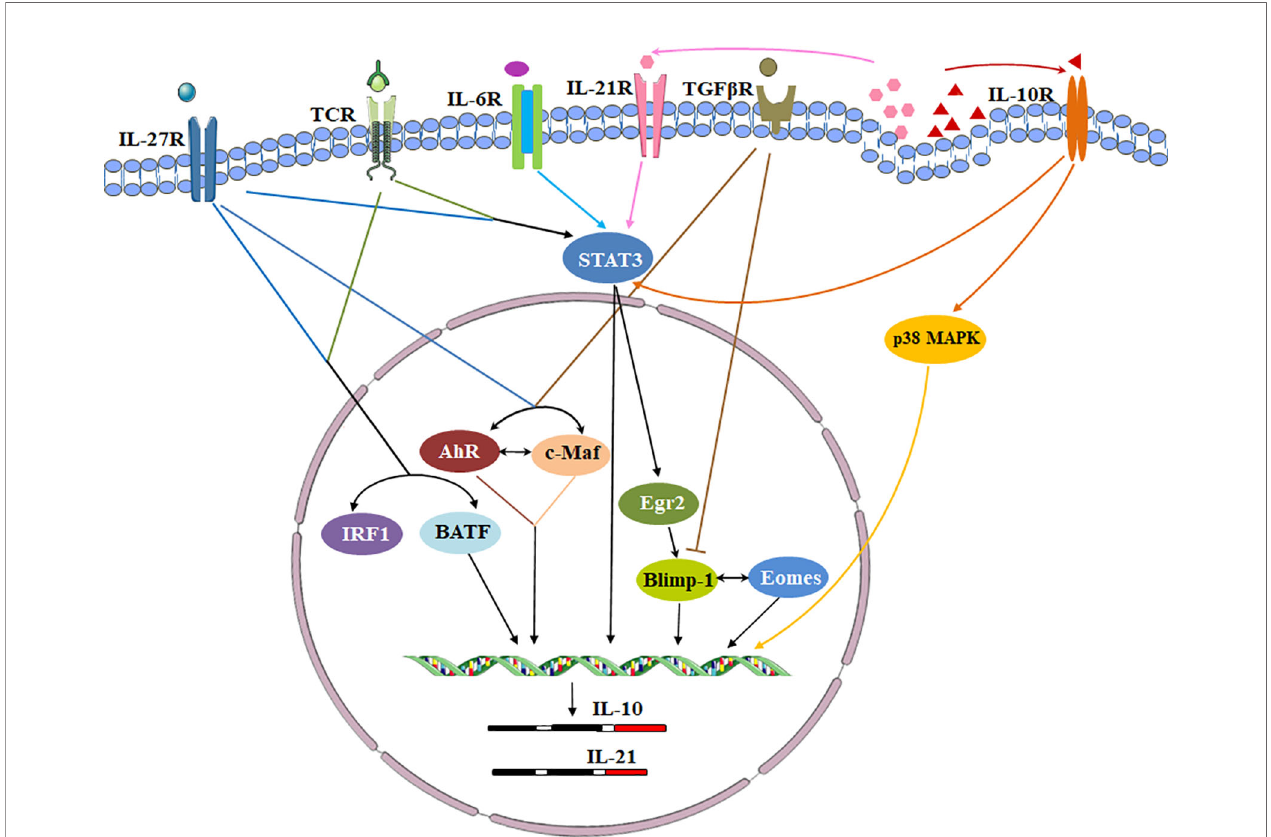
FIGURE 3 | Transcriptional regulation of signaling pathways during Tr1 cell induction. Cytokines, cytokine receptors and transcription factors establish a signaling transduction network to induce Tr1 cells in vitro and in vivo . IL-27 is a key cytokine in these pathways. IL-27 activates c-Maf and AhR. IL-27 along with TCR stimulation also induces high levels of Egr-2 which drives Blimp-1 expression. Conversely, TGF- b signaling antagonizes Blimp-1 by inducing AhR and c-Maf. c-Maf, AhR and Egr-2-Blimp-1 axis promote IL-10 and IL-21 secretion. The autocrine IL-10 and IL-21 maintain Tr1 cell stability via p38 MAPK and STAT3 respectively. Eomes is another key transcription factor. Eomes is dependent on IL-27, and interacts Blimp-1 to activate IL-10 expression. IRF1 and BATF which induced by TCR activation and IL-27 prepare the chromatin landscape for induction of the Tr1 gene network. IL-6 and other STAT3 activating cytokines might utilize the same transcriptional factors to generate Tr1